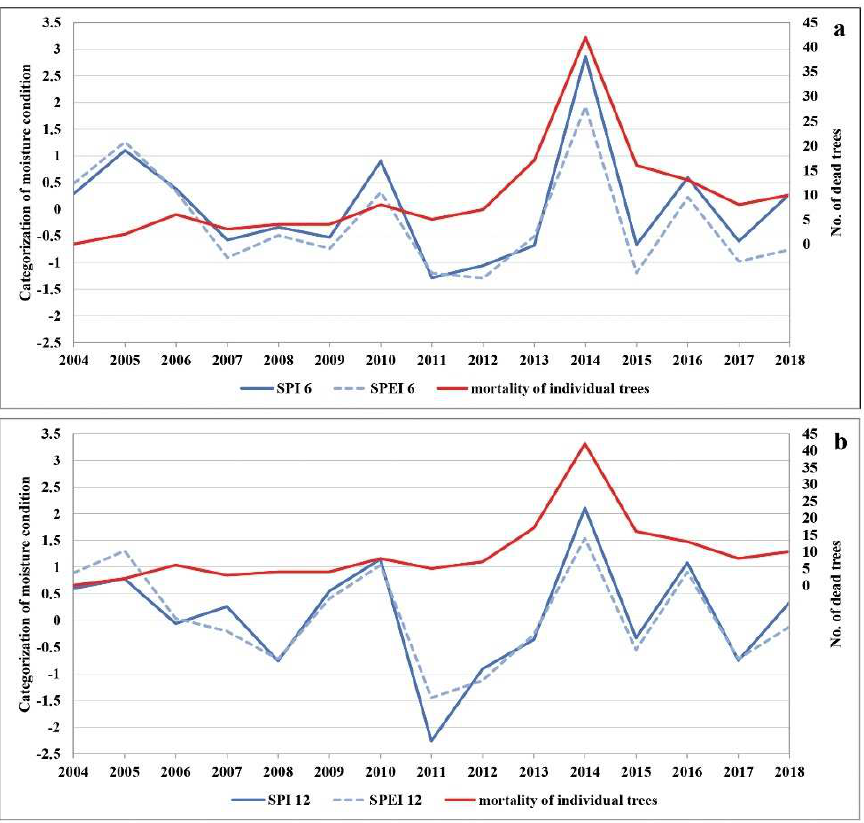
Figure 3. The comparison of ( a ) SPI-6 and SPEI-6 and ( b ) SPI-12 and SPEI-12 with the number of dead trees.